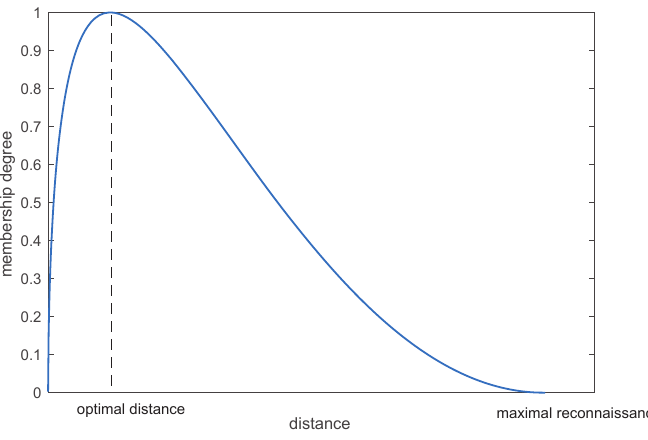
Figure 4. Radar’s working distance and membership degree.